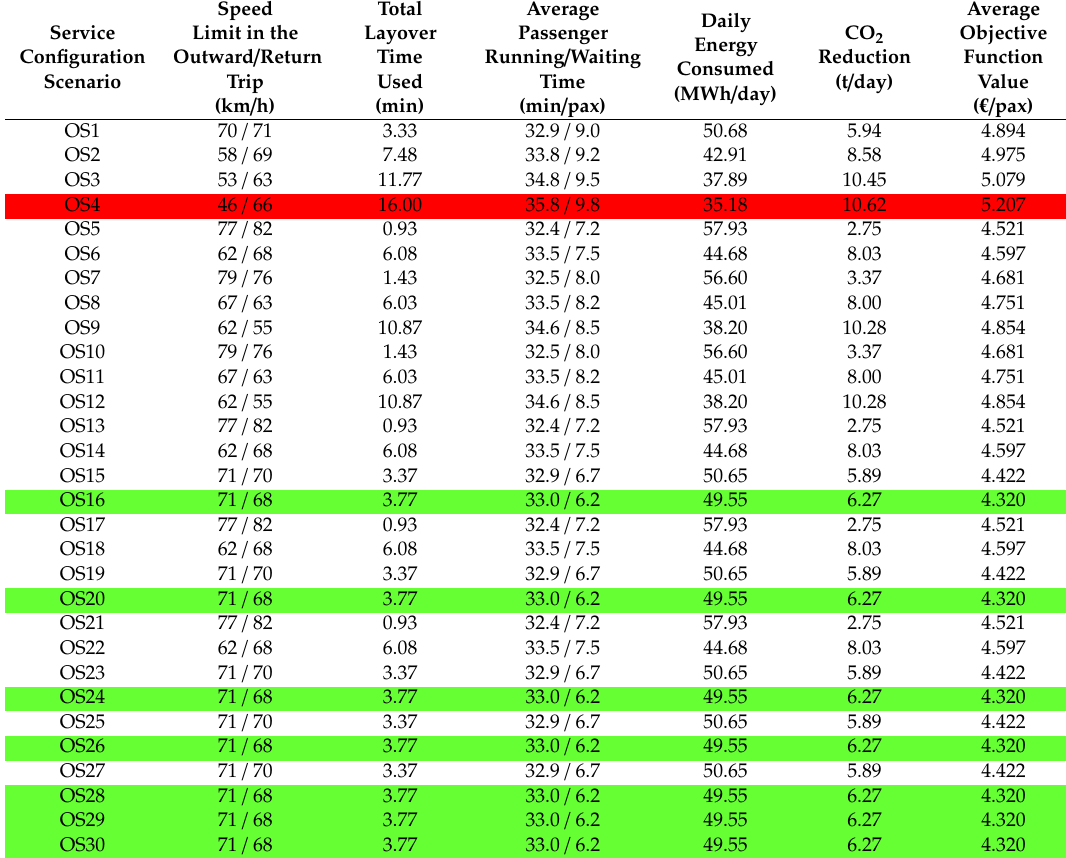
Table 5. Operational parameters in the case of an energy-saving strategy (ordinary